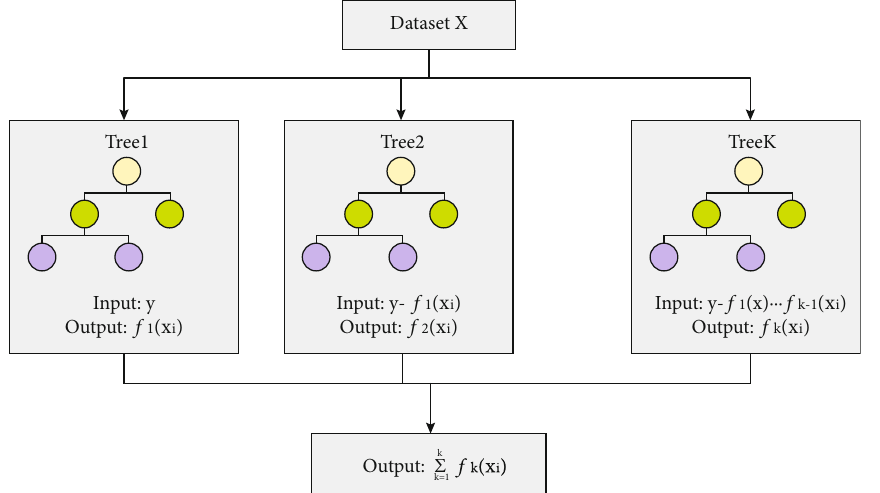
Figure 4: Flow chart of XGBoost